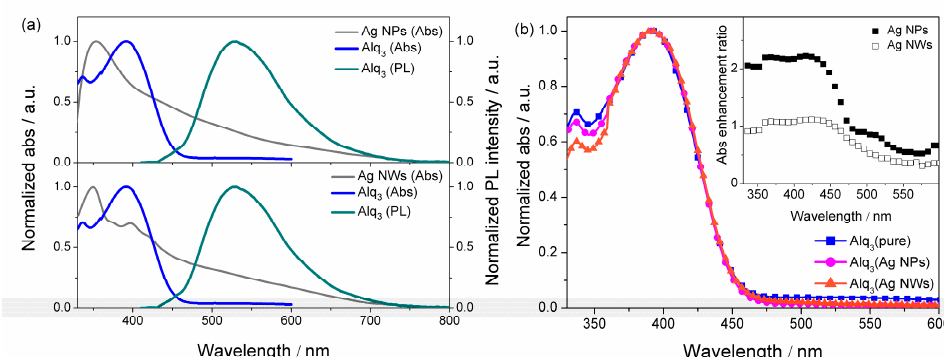
Figure 2. ( a ) Normalized absorption spectra of Ag nanostructures, and normalized absorption and PL spectra of Alq 3 (pure); ( b ) Normalized absorption spectra of Alq 3 (pure), Alq 3 (Ag NPs) and Alq 3 (Ag NWs); inset: the absorption enhancement ratio as a function of wavelength.